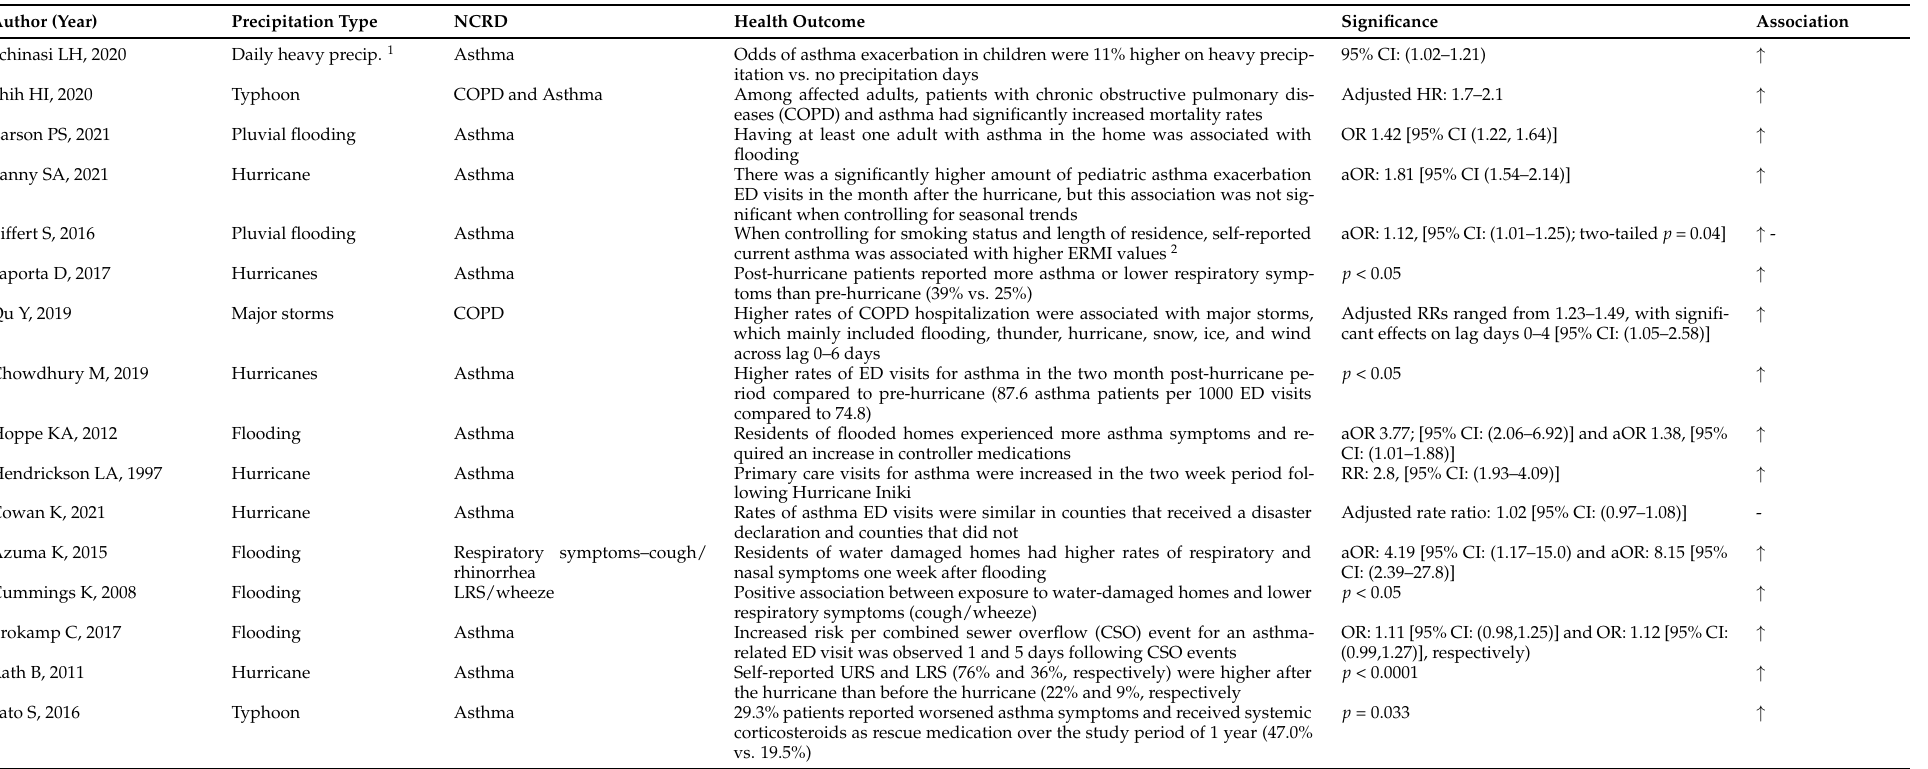
Table 3. Type of precipitation exposure, NCRD outcome, measured health outcome, statistical significance (where specified) and direction of association between exposure and outcome for each of the included